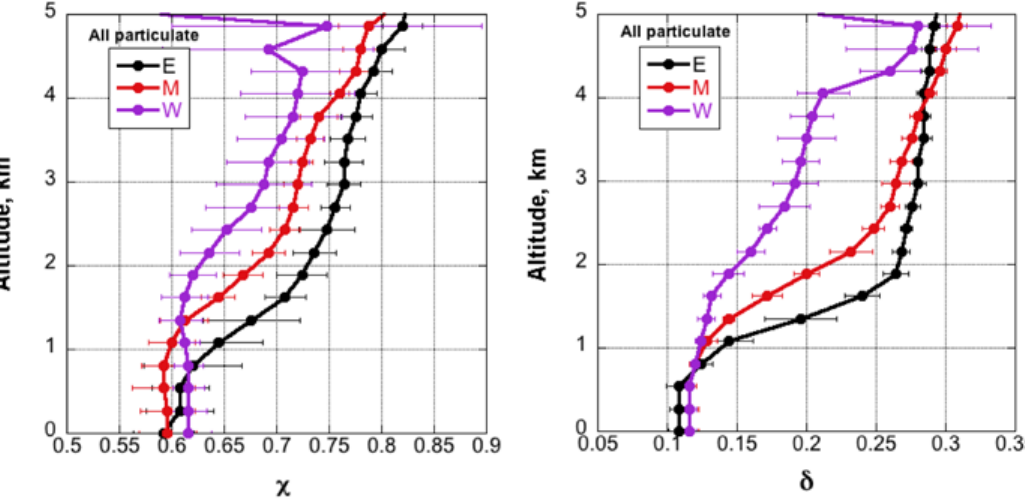
Fig. A1. Vertical distribution of retrieved dust particulate color ratio (left) and depolarization ratio (right). These plots correspond to Fig. 2b and d.